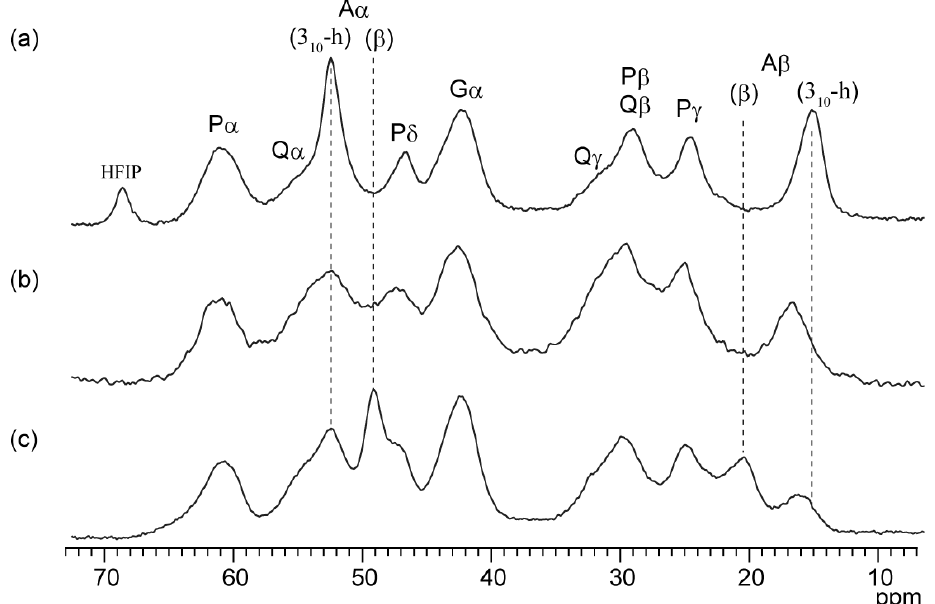
Figure 8 . 13 C CPMAS NMR spectra of RSP films prepared using different solvents: ( a ) HFIP, ( b ) DMSO, and ( c ) FA with peak assignments. Ala C α and C β are assigned secondary structures of a 3 10 -helix (3 10 -h) and a β-sheet (β), respectively.